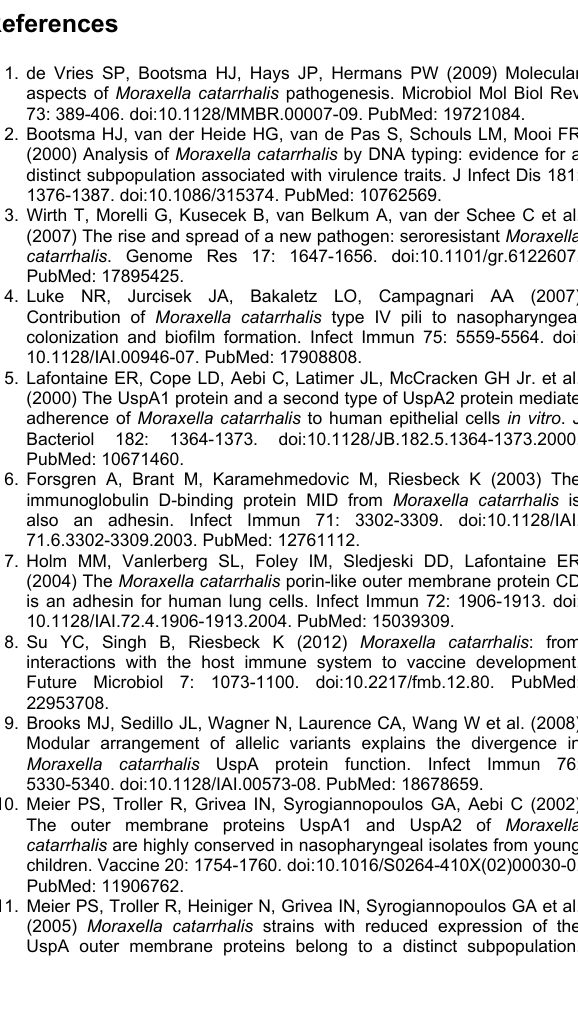
Table S1. Genes identified by Tn-seq that affect adherence of M. catarrhalis BBH18 to A549 and Detroit 562 cells.